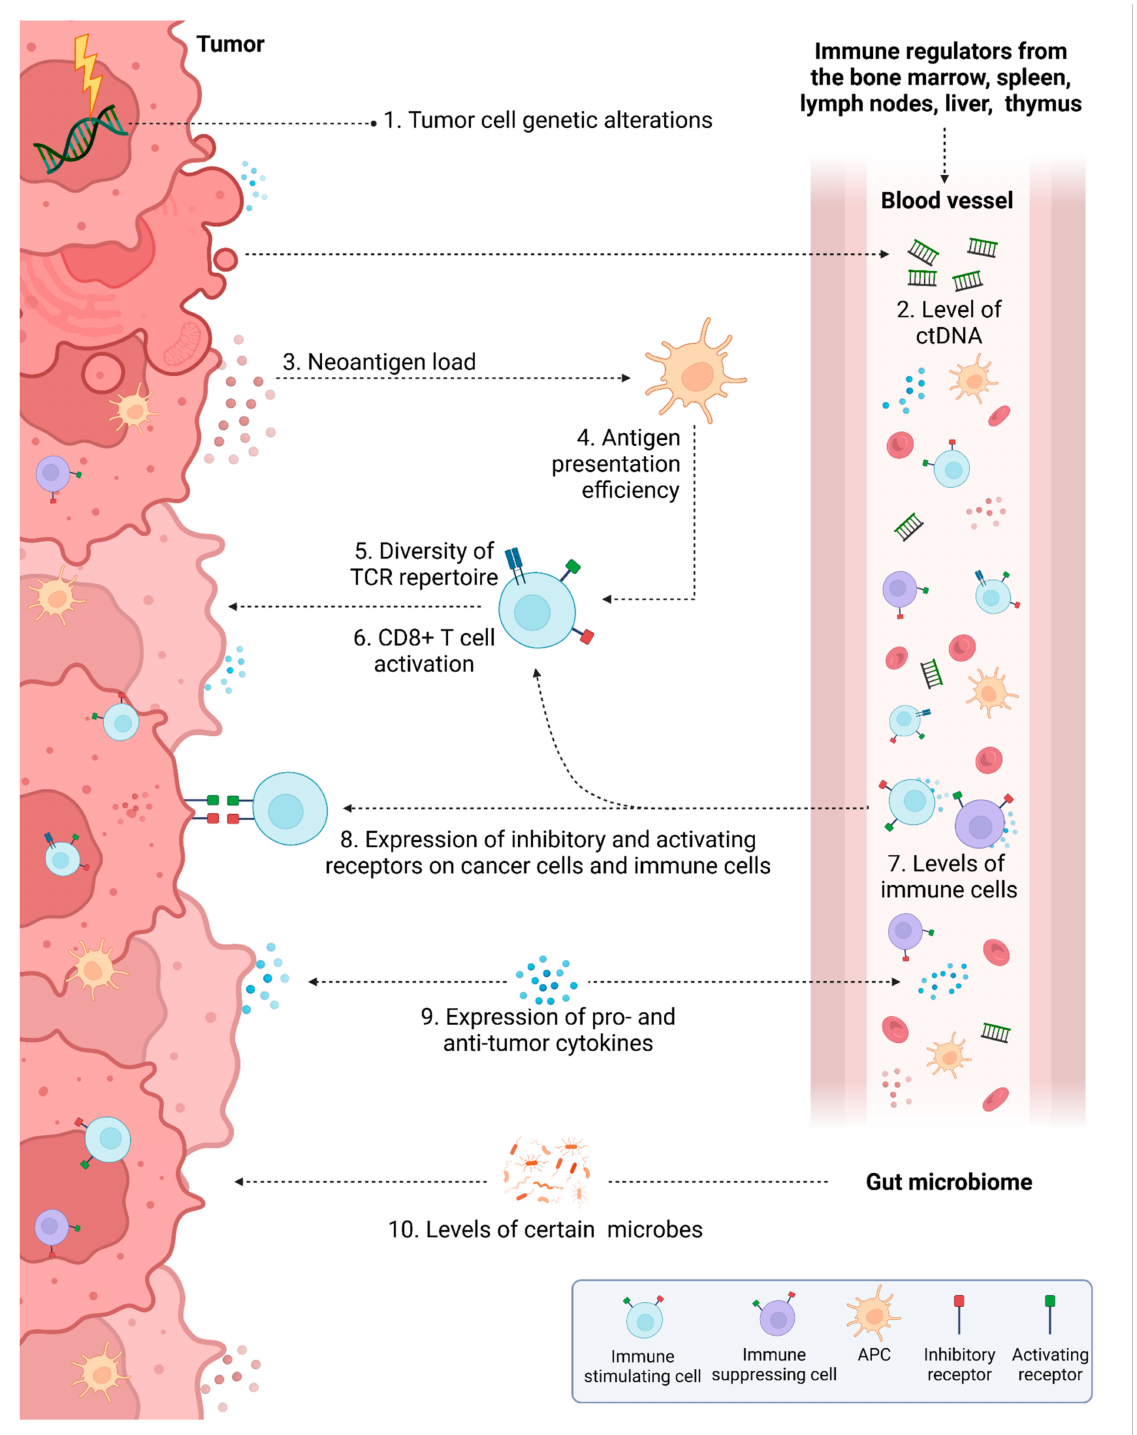
Figure 3. Key biomarkers of response to IT in CRC. (1) Certain genetic alterations in CRC cells have been associated with better response to IT. (2) A high level of ctDNA correlates with worse response to many cancer therapies including IT. (3) Neoantigen load is a key biomarker of response to several ITs including ICB. (4) High antigen presentation efficiency is associated with better response to T cell-based ITs. (5) Diversity of the TCR repertoire is associated with better response to IT. (6) A high level of CD8+ T cell activation is associated with better response to different ITs. (7) Levels of circulating and tumor-infiltrating immune cells including immune stimulatory cells (such as T cells and NK cells) and immune suppressor cells (such as T regs, MDSCs, and M2 macrophages),